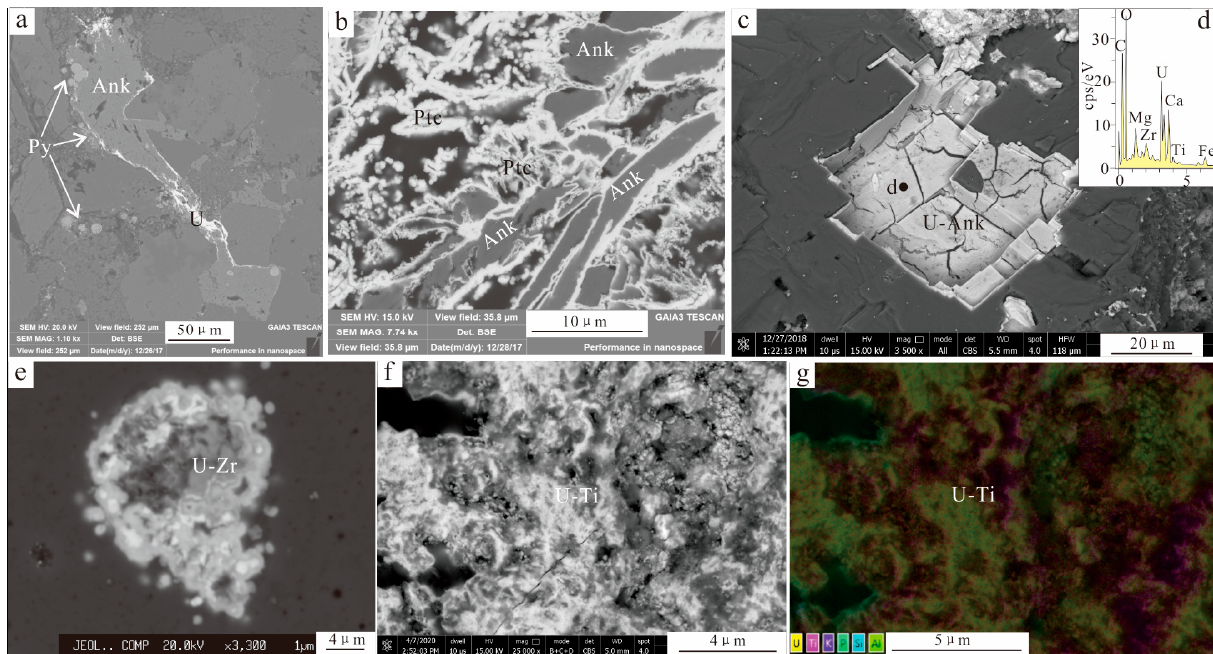
Figure 5. Micrographs of hydrothermal superimposed uranium mineralization from the lower member of Yaojia Formation in Qianjiadian ore field. ( a , b ) Pitchblende occurred at the edge of ankerite, ( c , d ) Euhedral uranium bearing iron dolomite and its energy spectrum, ( e ) Colloidal mixtures bearing uranium and zirconium, ( f , g ) Colloidal mixtures bearing uranium and titanium .Py: pyrite; Ptc: pitchblende; Ank: ankerite; U-Ank: uranium-bearing ankerite; U-Zr: mixtures containing uranium and zirconium; U-Ti: compound bearing uranium and titanium.